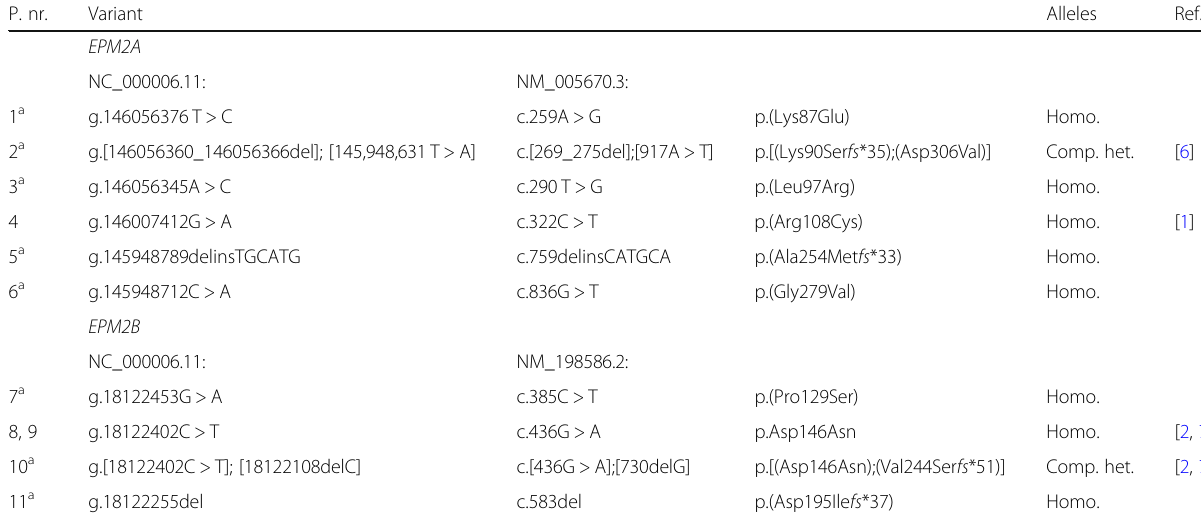
Table 1 Genotypes of LD patients living in Germany P.